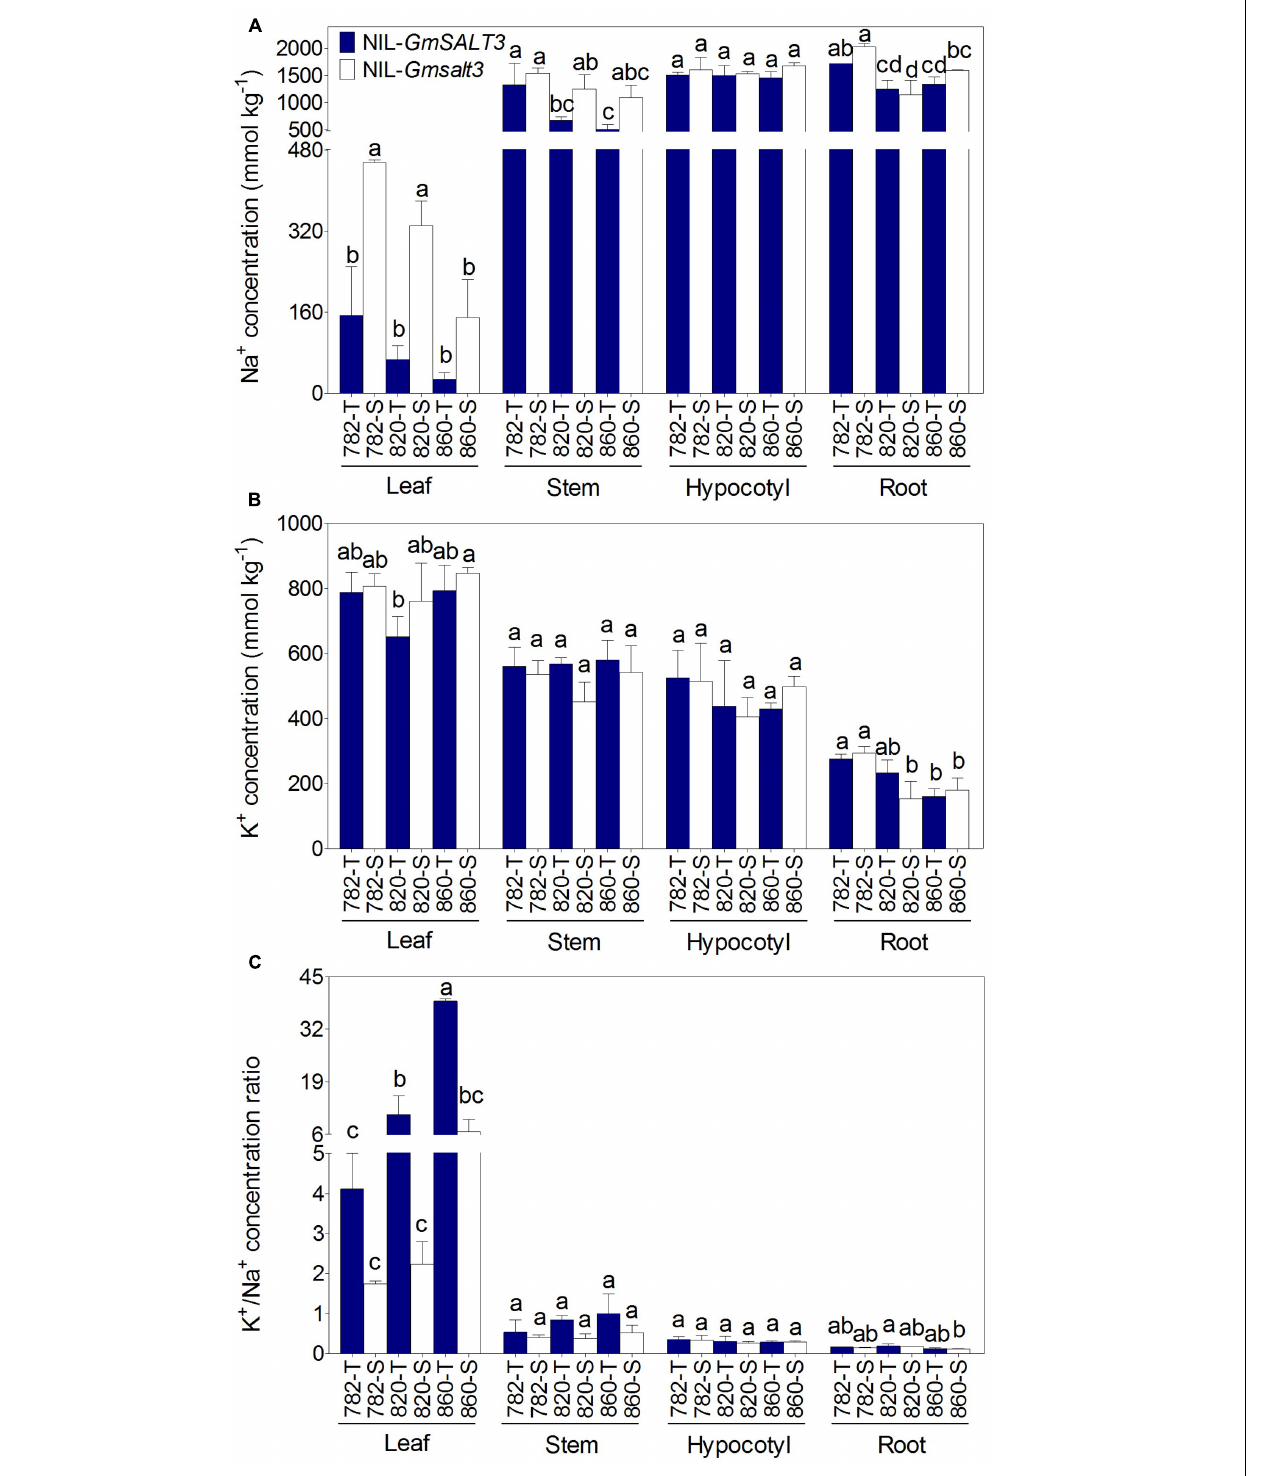
FIGURE 3 | Ion concentration (dry mass) in three sets of NILs after 10 days of NaCl stress (200 mmol L − 1 ; EC = 17.8 dS m − 1 ). (A) Tissue concentration of Na + in leaf, stem, hypocotyl and root of three sets of NILs. (B) Concentration of K + in leaf, stem, hypocotyl and root of three sets of NILs. (C) The K + /Na + ratio in leaf, stem, hypocotyl and root of three sets of NILs. Data are means of three replicates consisting of the mean values for five plants grown in the same pot ± SD ( n = 3). Different letters indicate statistically significant differences between NIL lines for each tissue (one-way ANOVA followed by Tukey’s HSD post hoc test, P <